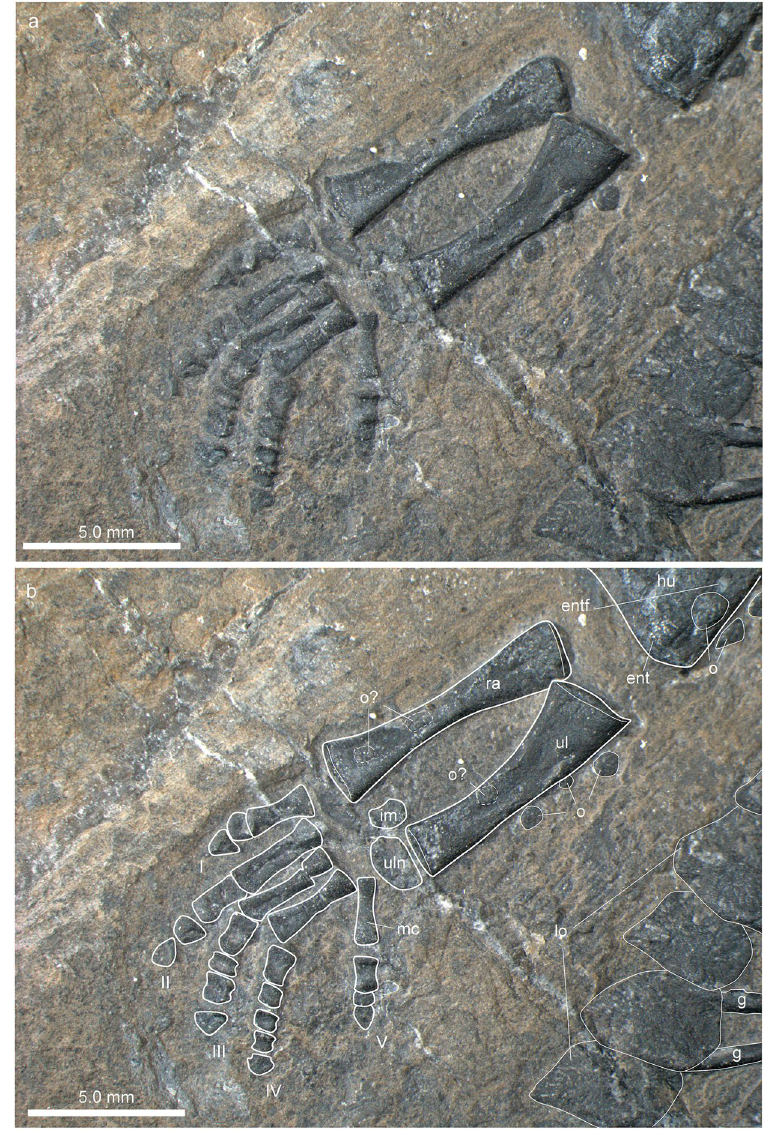
Figure 7. Zeugopodial and autopodial bones of the forelimb of Eusaurosphargis dalsassoi (PIMUZ A/III 4380). ( a ) Photograph. ( b ) Photograph overlain by interpretative drawing. Abbreviations used in the figure are entepicondyle (ent), entepicondylar foramen (entf), humerus (hu), intermedium (im), lateral osteoderm (lo), metacarpal (mc), osteoderm (o), radius (ra), ulna (ul), ulnare (uln), and digits 1 to 5